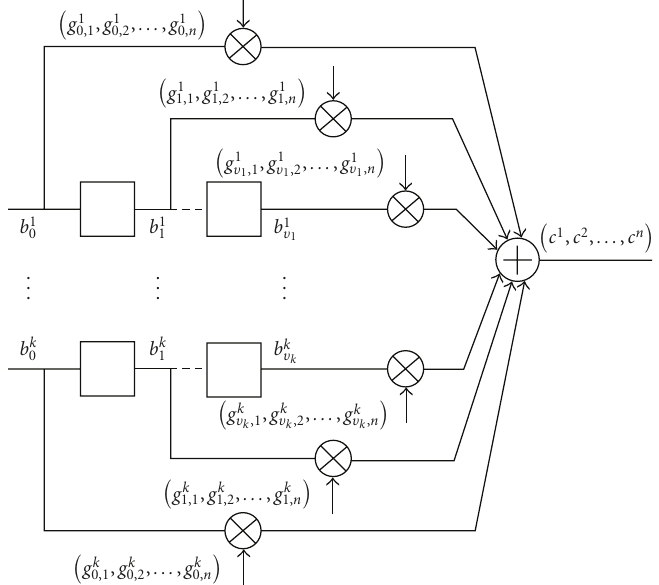
Figure 5: Cooperative trellis encoder.